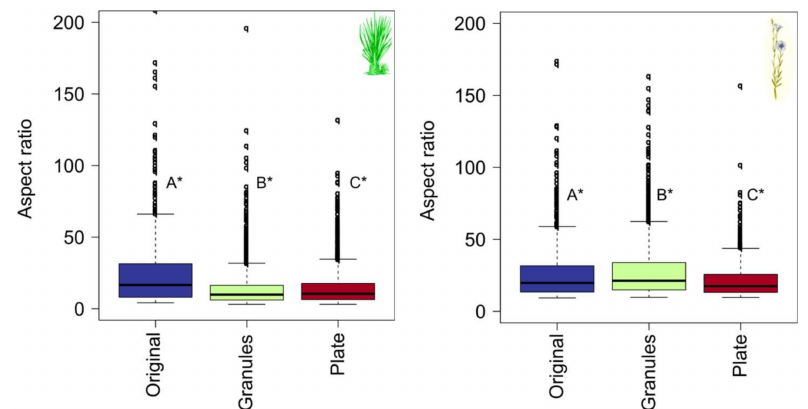
Figure 10. Distribution of the length ( left ) and width ( right ) for flax before processing (original), after compounding (granules), and after injection moulding (plate). The results are shown as box-and-whisker plots (whiskers with a maximum of 1.5 × IQR, outliers shown as circles). Boxplots with * represent not normally distributed samples and different capitals represent significant differences.